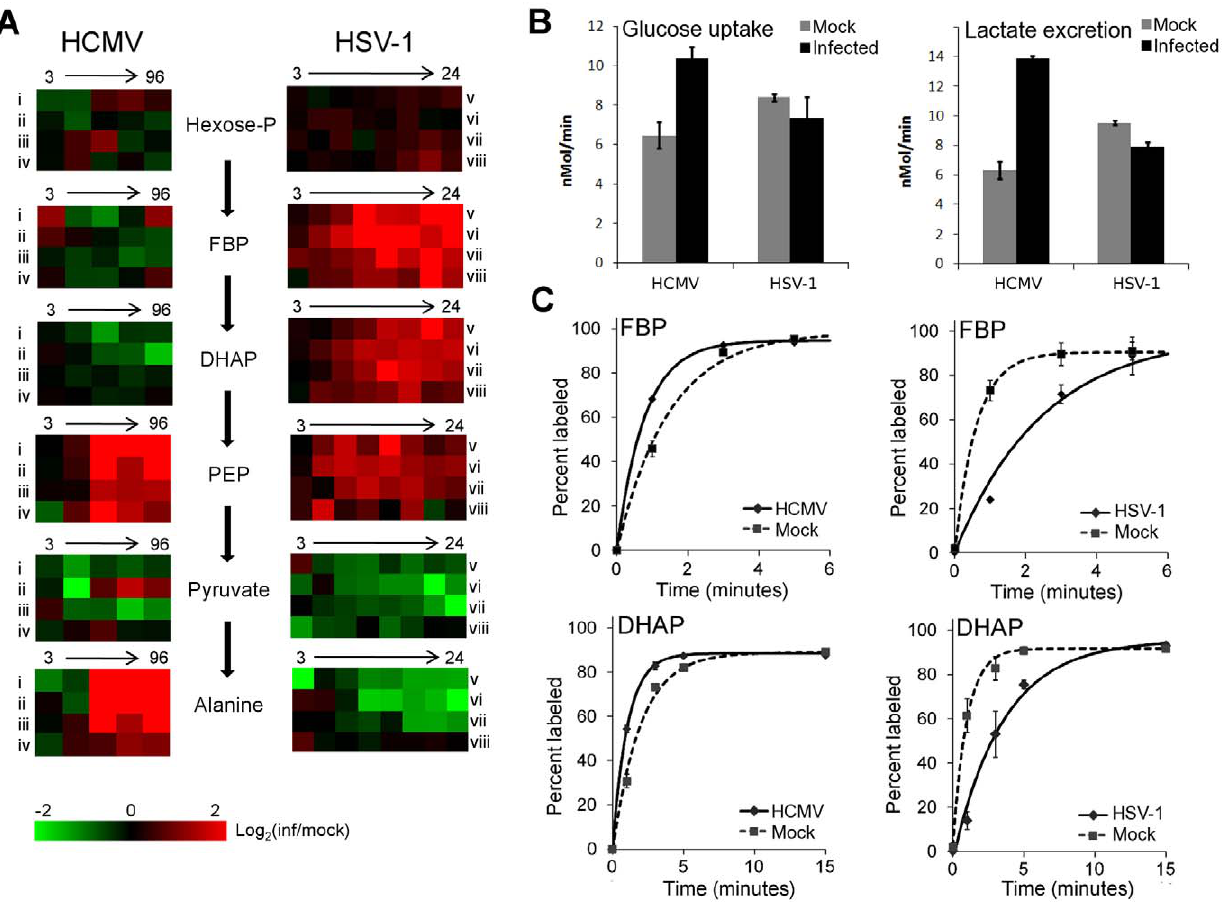
Figure 2. Perturbation of glycolysis by HCMV and HSV-1. ( A ) Plots of individual metabolite abundance during HCMV and HSV-1 infection. Data are the same as presented in Figure 1. Metabolite concentrations are expressed relative to equivalent mock-treated cells. Rows correspond to infection time courses of the following virus strains and cell types: (i) TB40-HFF, (ii) AD169-HFF, (iii) AD169-MRC5, (iv) TB40-ARPE19, (v) F-HFF, (vi) KOS- HFF, (vii) KOS-MRC5, (viii) KOS-Vero. Columns correspond to time points: 3, 24, 48, 72, 96 hpi for HCMV and 3, 6, 9, 12, 15, 18, 21, 24 hpi for HSV-1 (Hexose-P: glucose-6-phosphate and its isomers; FBP: fructose-1,6-bisphosphate; DHAP: dihydroxy acetone-phosphate; PEP: phosphoenolpyruvate). ( B ) Measurement of glucose uptake and lactate excretion rates in HCMV-AD169 or HSV-KOS infected, as well as mock-treated, human foreskin fibroblasts (mean 6 2 s.e.; n=3). ( C ) Buildup of the labeled fraction of the FBP and DHAP pools after switching cells to uniformly 13 C-labeled glucose medium at 12 hpi during HSV-KOS or 48 hpi during HCMV-AD169 infection or equivalent virus-free treatment of HFF cells. Symbols indicate experimental data points 6 2 s.e.; n=2; lines indicate exponential fit.